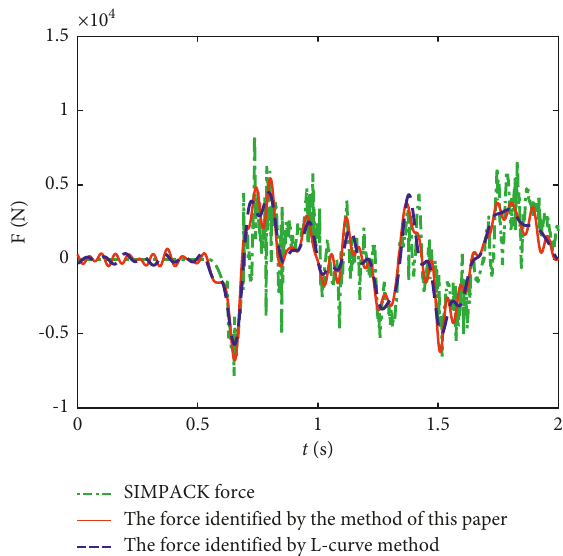
2 Figure 13: Load time-history diagram of the two methods for F identification when the noise level is